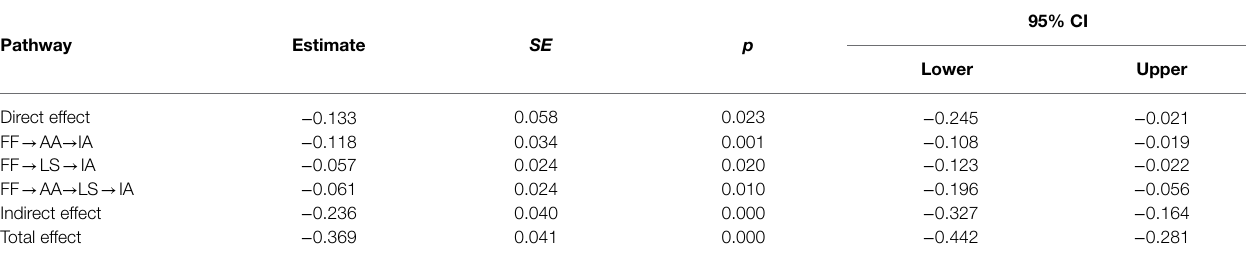
TABLE 2 | Direct, indirect and total effects of the pathways tested.